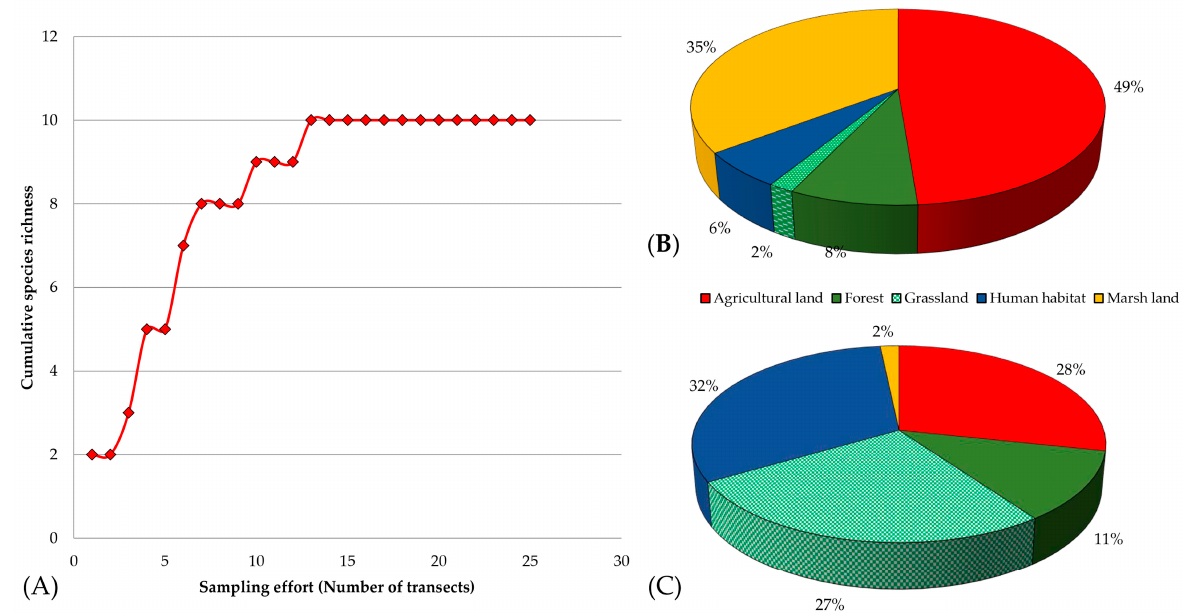
Figure 3. Herpetofaunal community structure in different habitats of the RWC; ( A ) Species accumulation curve of herpetofauna; ( B ) The abundance of amphibians in different habitats; ( C ) The abundance of reptiles in different habitats.